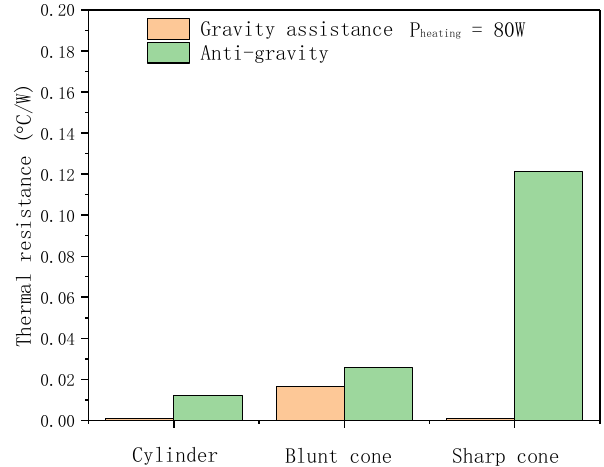
Figure 7. Thermal resistances of heat pipes with different kinds of vapor chambers.